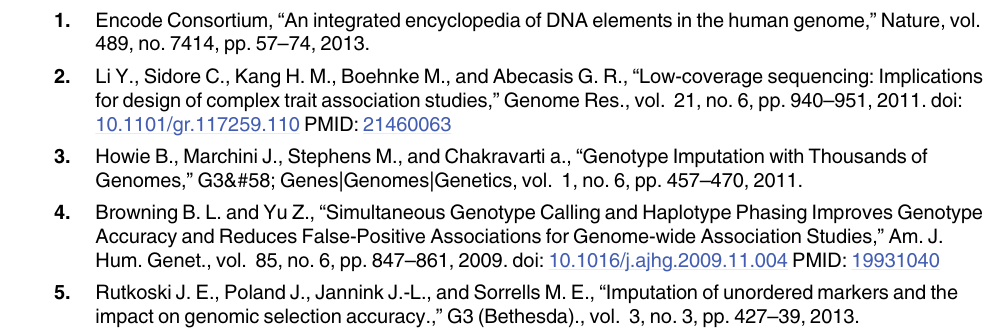
C1 population appear as red dots with diameters scaled proportionally to the number of off- spring contributed by the individual. S4 Fig. Distribution of the proportion of missing data per biallelic SNP. The proportion of missing data at a given site is measured across the 694 GG individuals. The term “ missing ” denotes zero reads observed at a given site for a given individual. We removed sites with > 90% missing data, leaving a total of 20205 sites for cross-validation experiment 1. We used this same set of sites for scenarios 2 and 3 for reasons given in the main text. S5 Fig. Distribution of the mean read depth per site. (A) The histogram shows the distribu- tion of the mean read depth per site averaged across all 694 GG individuals. (B) The histogram shows the distribution of the mean read depth per site averaged across all 696 reference panel individuals. The red vertical line marks the mean of the distribution. S1 Table. Members of the GG population. S2 Table. Pedigree records for C1